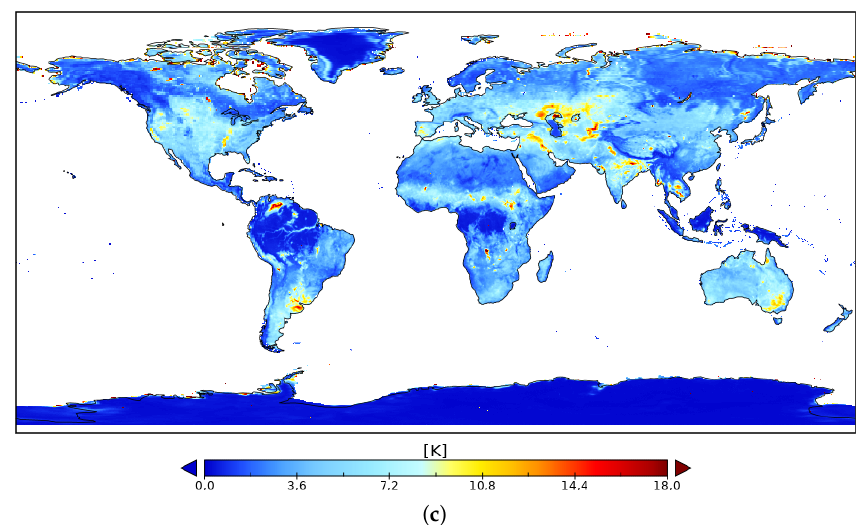
Figure 15. Maps of the adjusted error standard deviation of TB ( σ δ (mean error std: 7.62 K and gaps: 0.05%,), ( b ) SMOS NS (mean error std: 6.62 K and gaps: 0.29%), and ( c ) SMAP (mean error std: 3.2 K and no gaps per construction).